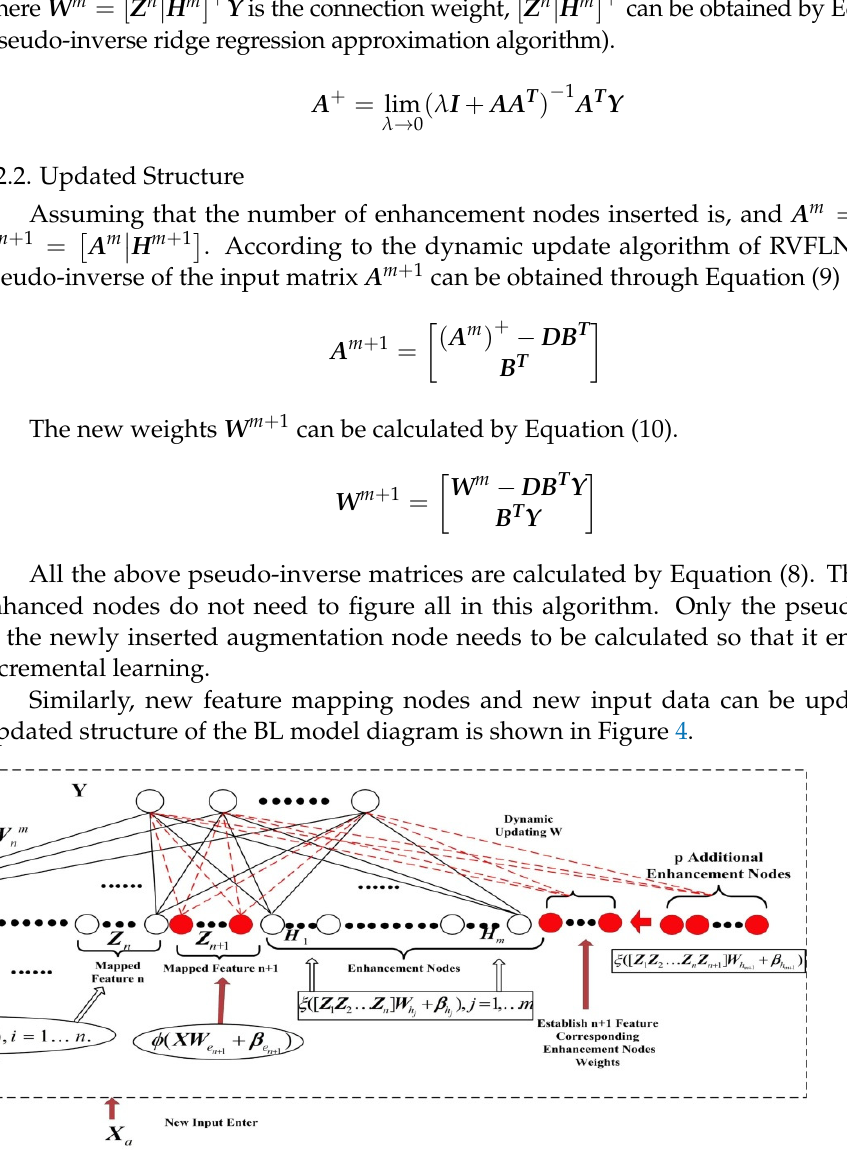
Figure 4. Updated structure of the BL model.